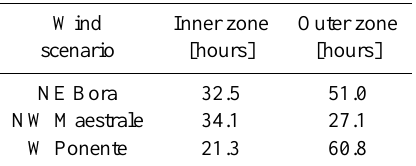
Fig. 19. Contour plots of the west-east (u) instantaneous velocity component in the vertical cut indicated with black line in the small picture on the right side, for the three scenarios considered: a) Bora; b) Maestrale; c) Ponente. The black lines indicate instantaneous stream-tracers.